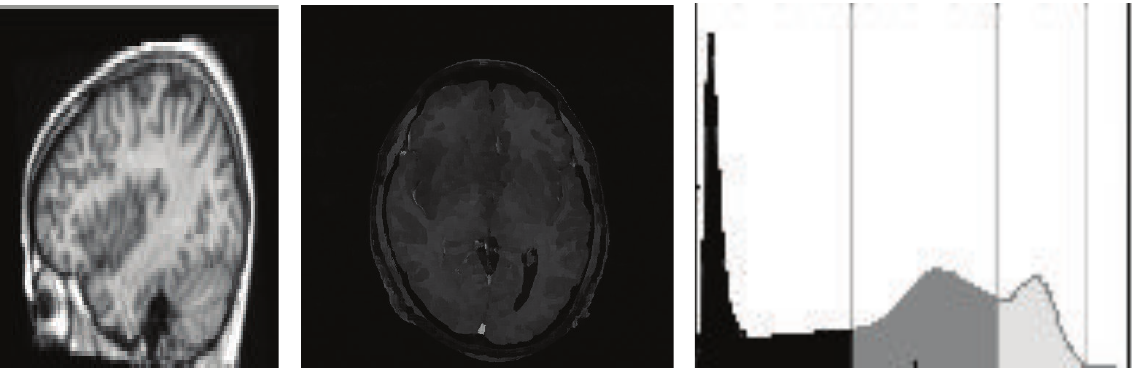
Figure 2: Normalized 3D LoG filter